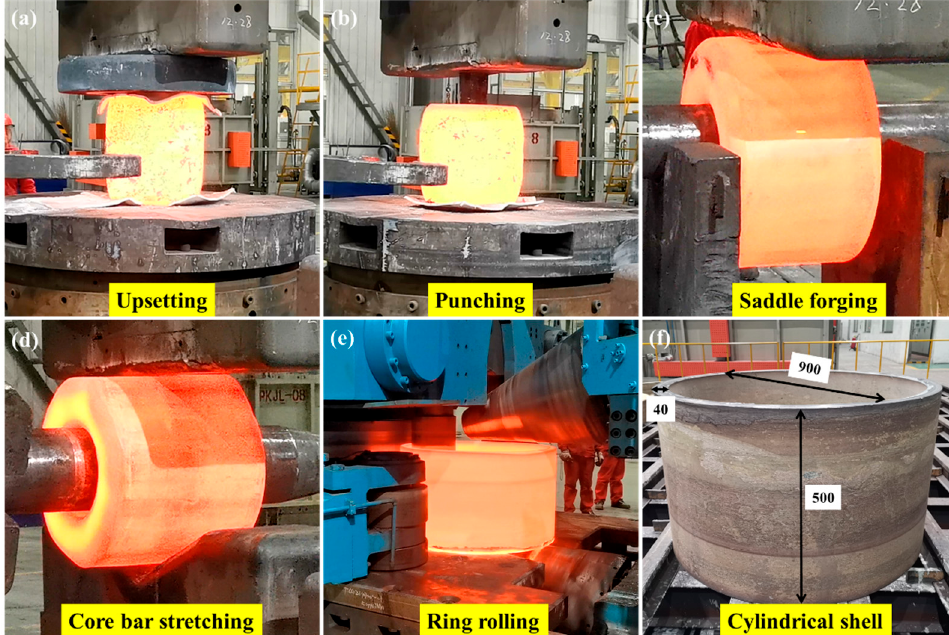
Figure 1. The forging process of the TA31 cylindrical shell through ( a ) upsetting, ( b ) punching, ( c ) saddle forging, ( d ) core bar stretching and ( e ) ring rolling; and ( f ) the size of the cylindrical shell (units is mm).